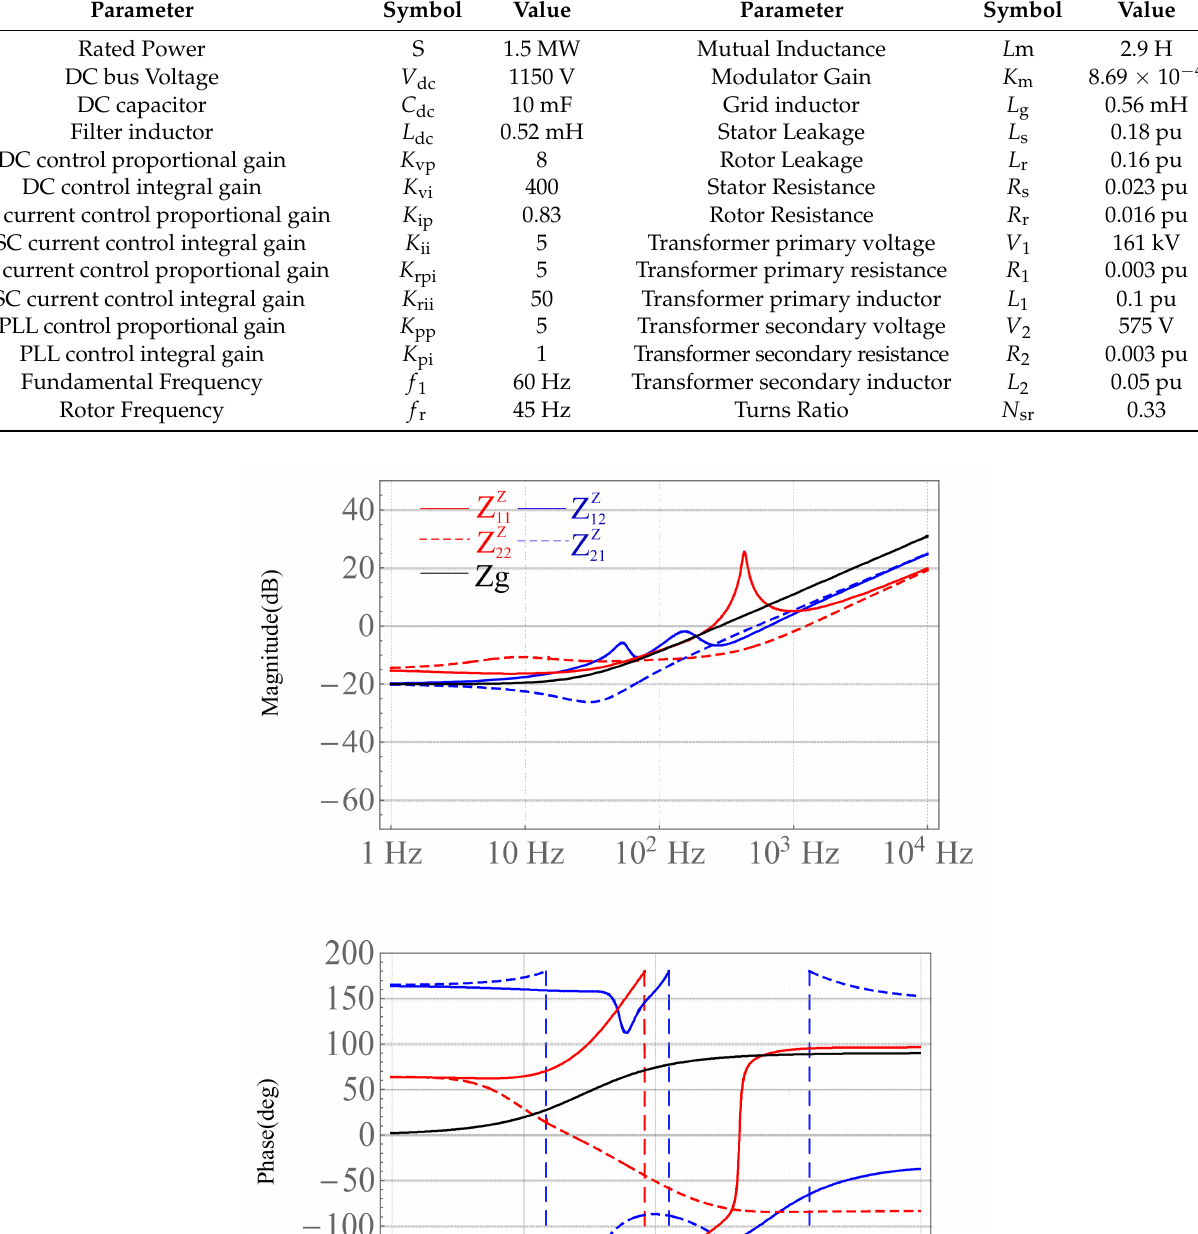
and Z Z are the 22 11 and Z Z are the frequency 12 21